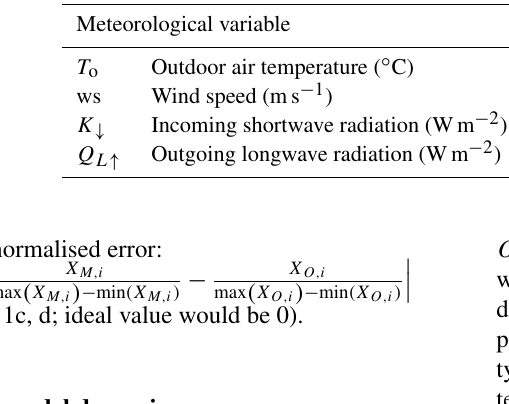
Table 5. Observed meteorological variables at King’s College London KSSW site, 60.9m above ground level (Kotthaus and Grimmond, 2014; Ward et al., 2016). See Fig. 1a in Kotthaus and Grimmond (2014) for site location. From these other variables are derived.